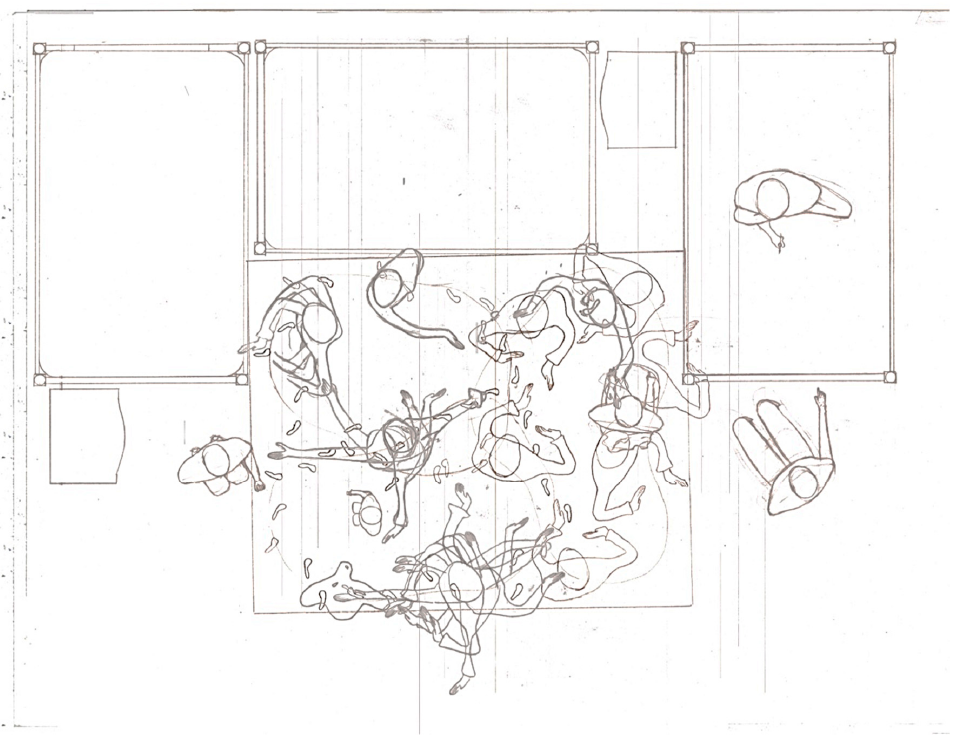
Figure 3. Planar dance movement mapping.